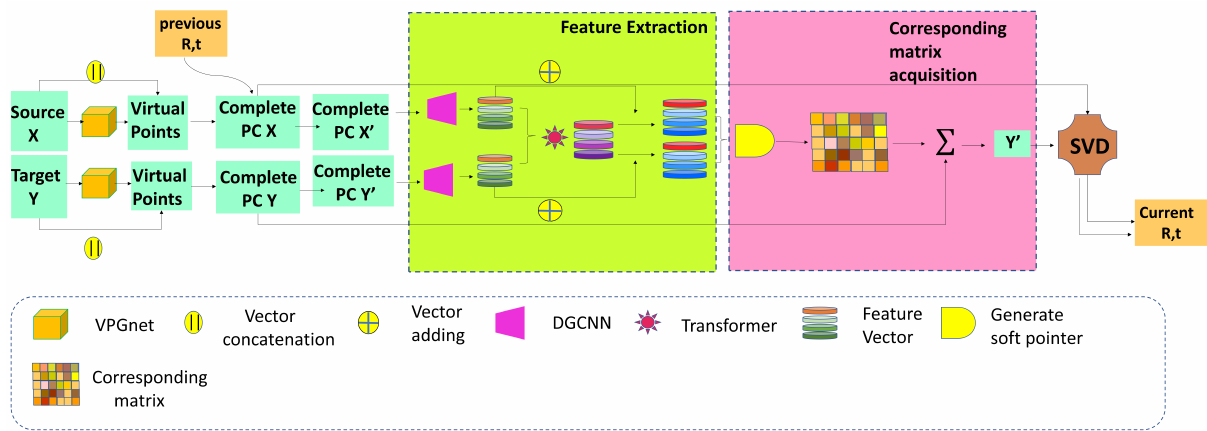
Figure 2. Architecture of our registration network. The iterative network first applies the rotation and translation calculated in the previous iteration to the input cloud. Through two main components of feature extraction, including Transformer and corresponding matrix acquisition, the network obtains the rigid transformation of the current iteration through